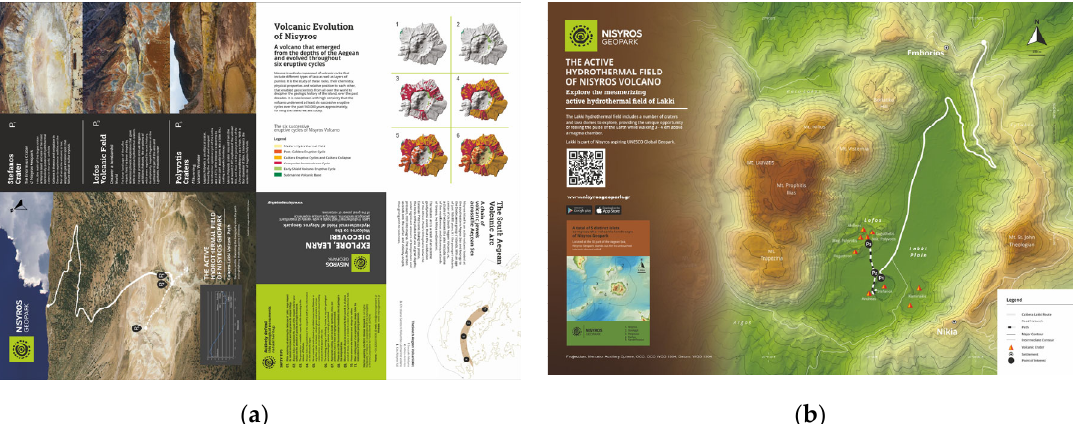
Figure 15. Prototype images of the full extent of the foldable poster (fifth foldable level): ( a ) Back view presenting all the successive fold levels described above; ( b ) Front view representing the topographical area of Lakki, within the caldera of Nisyros, along with the georoute, the trail connecting the points of interest and the location of the most famous hydrothermal craters.